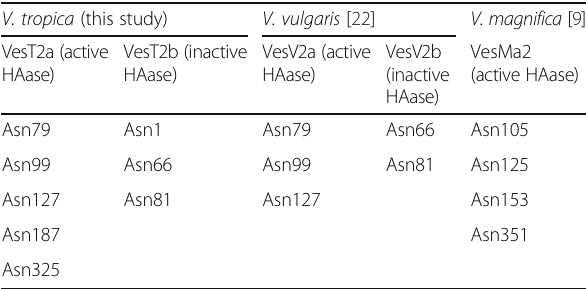
Table 3 N -glycosylation in wasp venom HAase. Asn-Xaa-Ser/Thr residues represent the possible N -glycosylation sites predicted